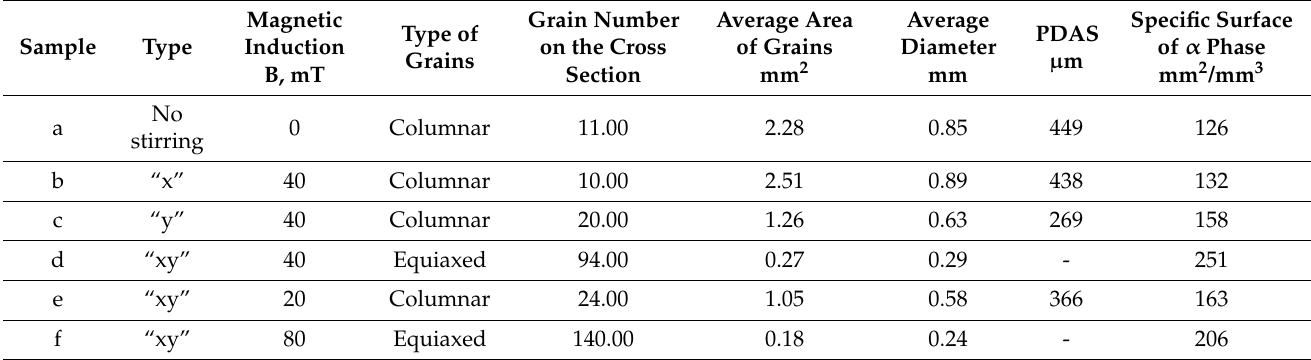
Table 1. Parameters of Experiment 2 and the grain and dendritic